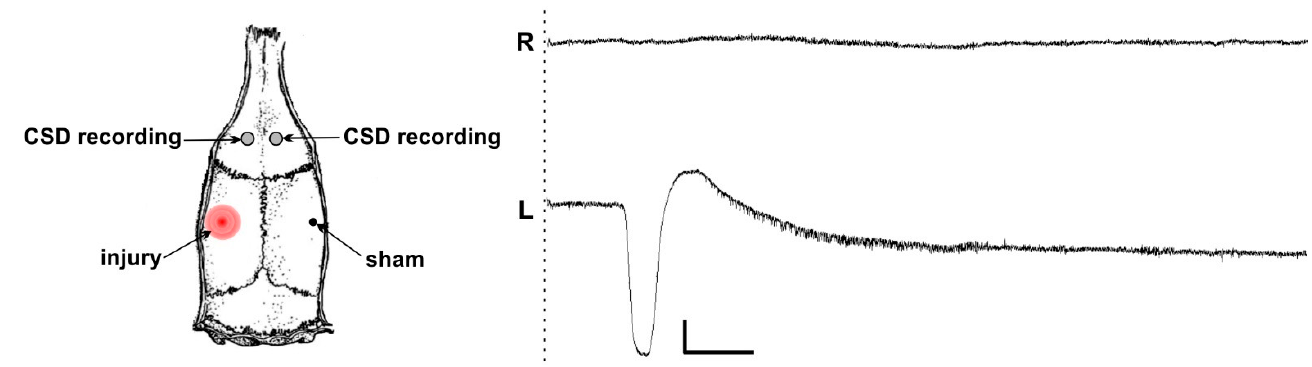
Figure 1. A single unilateral cortical spreading depolarization (CSD) induced by a local parenchymal injury of the somatosensory cortex and its propagation to the ipsilesional frontal cortex of an awake rat. Scheme shows the localization of the cortical microinjury, sham stimulation, and recording electrodes. A representative trace shows a single injury-induced CSD propagated to the left frontal cortex (L) but not invaded the contralesional right frontal cortex (R). The time of microinjury is marked by dashed line. Scale bars—50 s and 2 mV. Negativity is directed